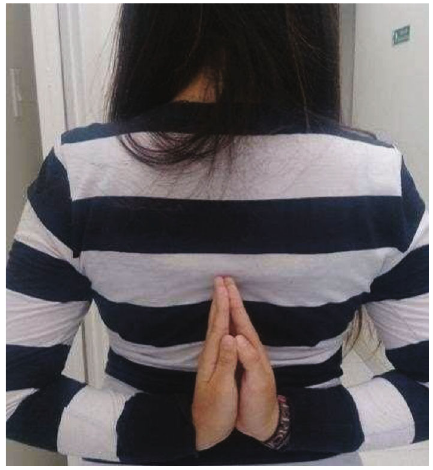
Figure 2: Hyperlaxity in the elbow.